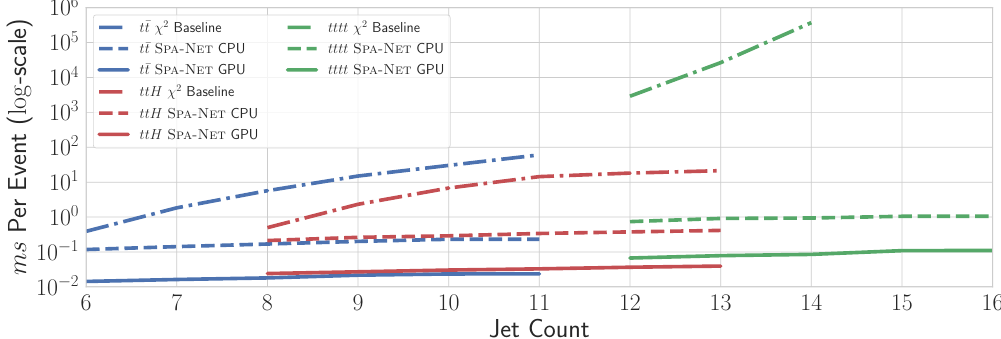
Figure 3: Average run-time for jet-assignment inference of S PA -N ET and χ 2 on various events and jet multiplicities over 1000 runs. S PA -N ET s were evaluated with a batch size of 1024 events. Timings are performed on an Intel I7 10700K CPU with 64 GB of RAM and Nvidia 3080